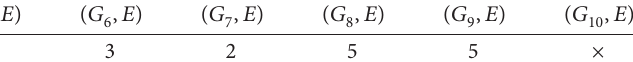
Table 3: The value of ( G